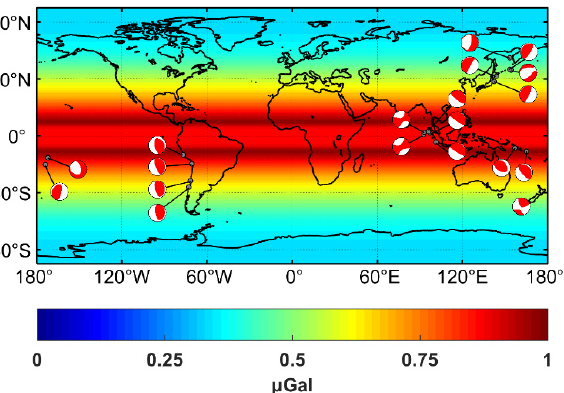
Figure 1. Global mean and standard deviation of monthly time-variable gravity field model errors.